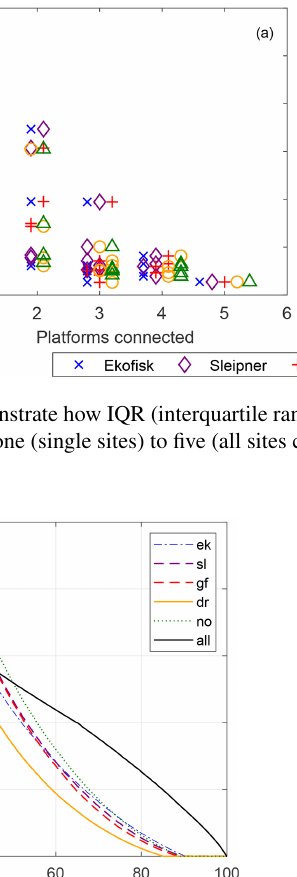
Figure 8. Given a pairwise connection, this figure shows the me- dian P w -production for a site given that the other site are not pro- ducing at all ( P w = 0) as a function of the distance between the connected site